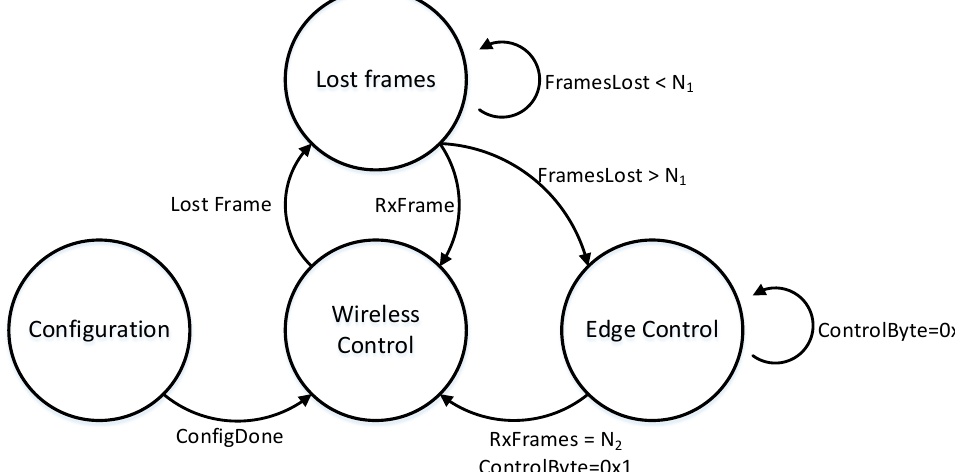
Figure 3. Operational states and transitions for the wireless control system.